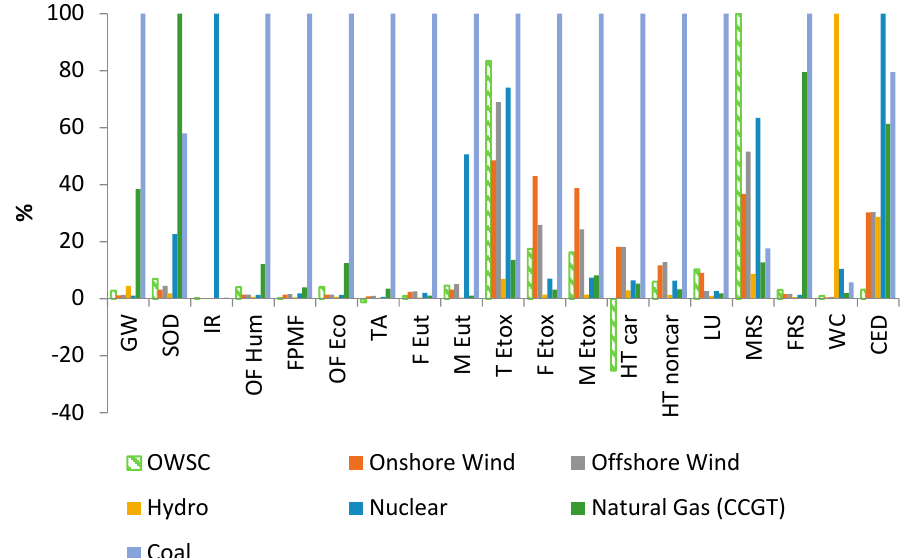
Figure 10. Comparison of impacts of MegaRoller with other forms of energy production, pre-sented relative to the highest score in each category.